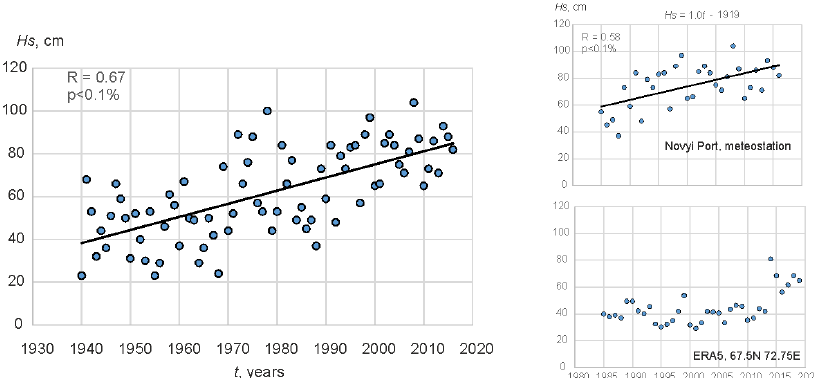
Figure 20. Spatial distributions of mean annual H s , its temporal variability C v and skewness C s. on the Yamal peninsula.